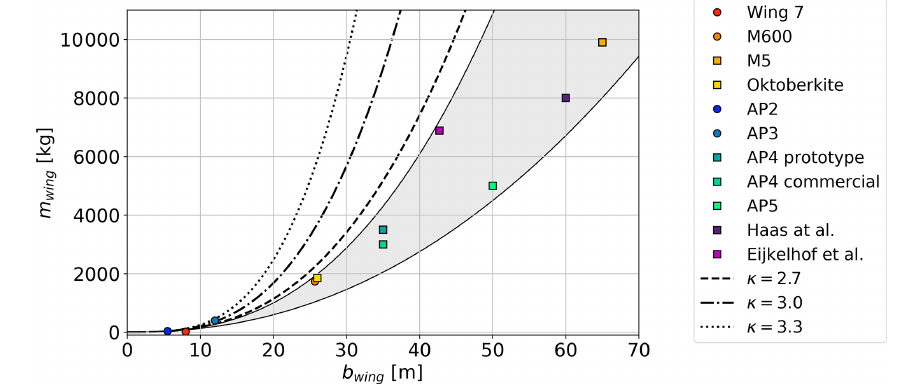
Figure 3. Published AWES aircraft masses (Haas et al., 2019; Kruijff and Ruiterkamp, 2018; Eijkelhof et al., 2020; Ampyx, 2020; Echeverri et al., 2020). Circular markers indicate built prototypes, while square markers show estimated designs. For these data, the scaling exponent ranges between κ = 2 . 2–2.6 (gray area). The here-investigated, more conservative mass scaling exponents between κ = 2 . 7–3.3 are depicted by dashed, dash-dotted and dotted lines.